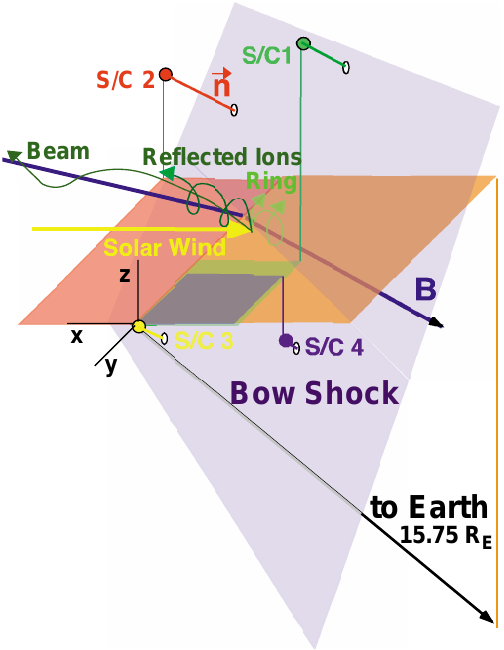
Fig. 2. Orientation of the bow shock at the location of the Clus- ter spacecraft and their relative position in space for 24 January 2001. The colored areas and the vertical lines indicate the posi- tion of spacecraft 1, 2 and 4 relative to the reference spacecraft 3. The spatial orien-tation of the vector pointing towards the Earth is shown in a similar way (not to scale). The short lines from the spacecraft towards the shock (light blue shaded area) indicate the relative distance of the three spacecraft from the shock upon their